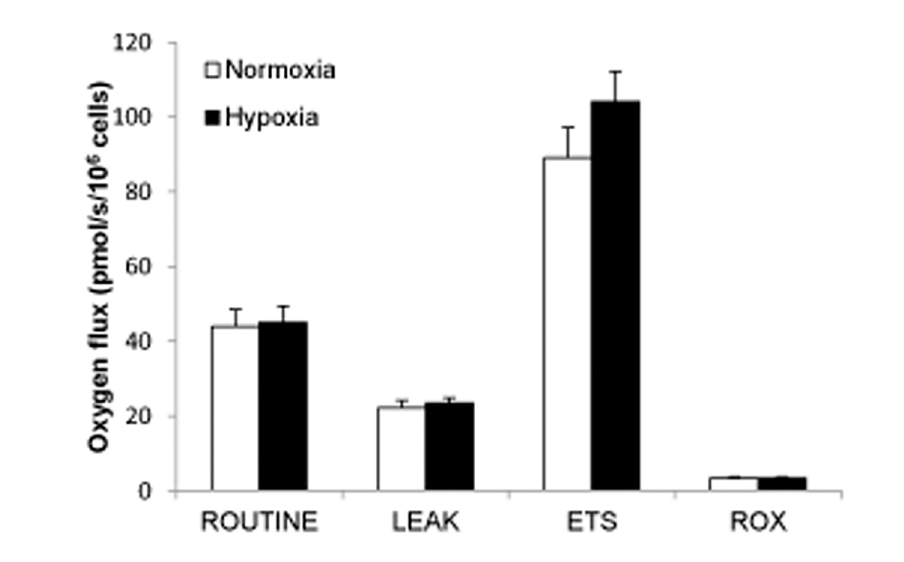
Fig 4. Oxygen flux in different respiratory states in intact INS-1 832/13 cells. Sequential respiratory states in the Protocol Int protocol, comparing hypoxia with normoxia ROUTINE: basal respiration measured at physiological substrate conditions, before any reagent additions, LEAK: uncoupled respiration after addition of oligomycin, ETS: flux capacity of the electron transfer system, induced by FCCP, ROX: residual oxygen consumption, a measure of oxidative side reactions obtained by adding rotenone and antimycin A to inhibit complex I and II, respectively. Fluxes are expressed as means ± SEM of five experiments (comprising totally 12 single measurements), * P < 0.03.